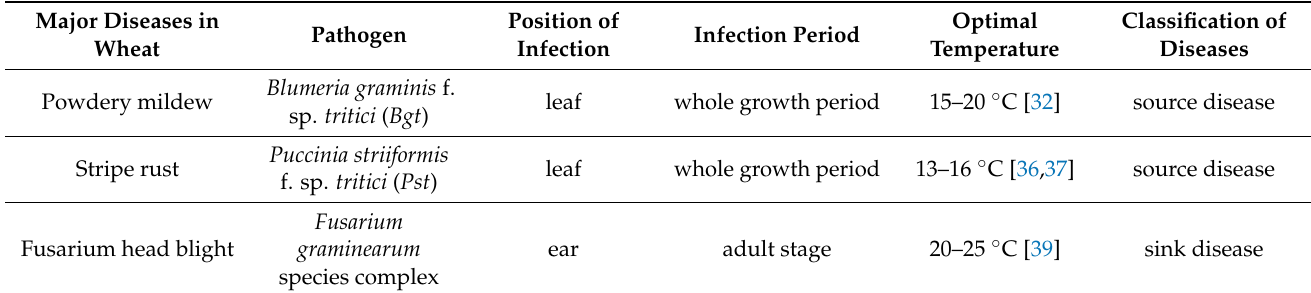
Table 1. Characteristics of the three major fungal diseases of